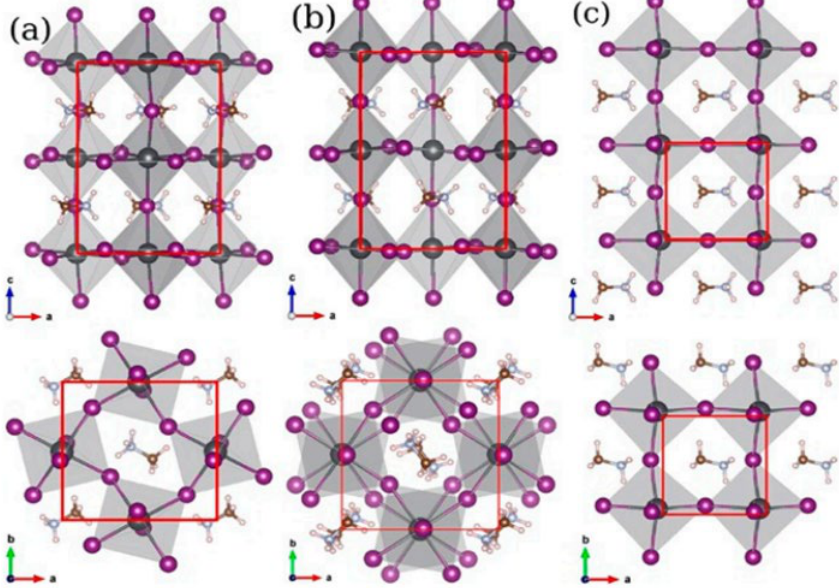
Figure 2. MAPbI 3 phase transitions arranged in order of increasing temperature ( a ) orthorhombic, ( b ) tetragonal, and ( c ) cubic perovskite phases [34]. ( b ) tetragonal, and ( c ) cubic perovskite phases